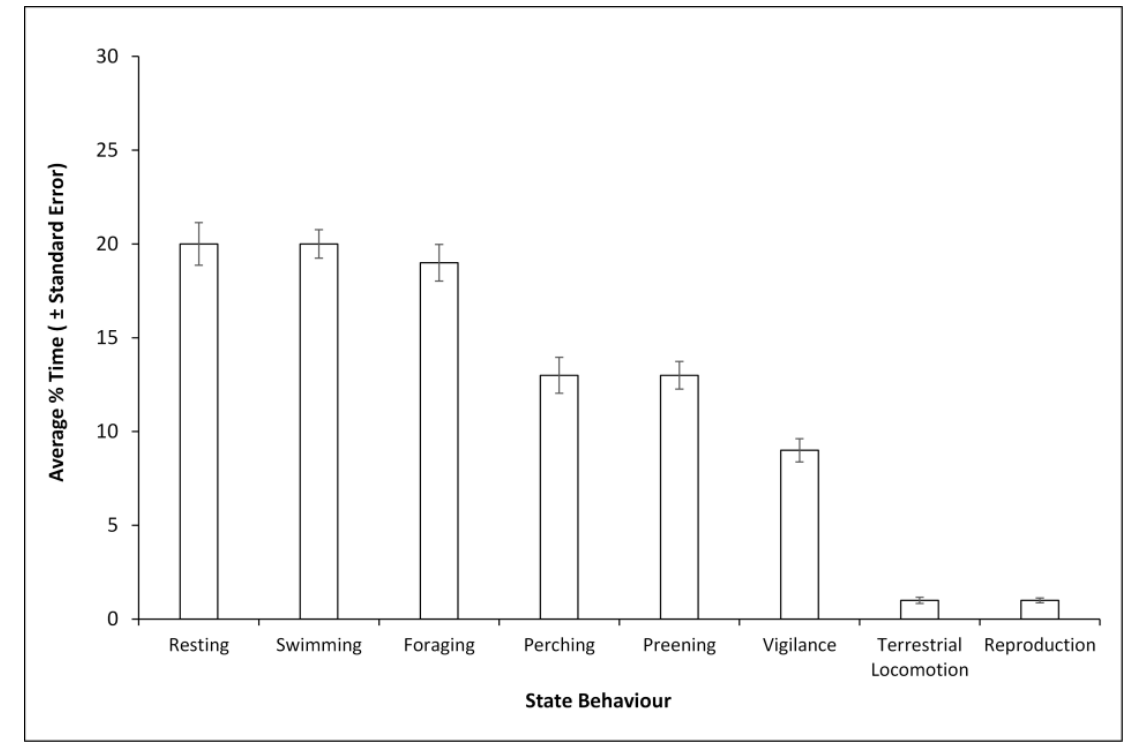
Figure 3. Average time budget (%) of Mandarins during the breeding season.